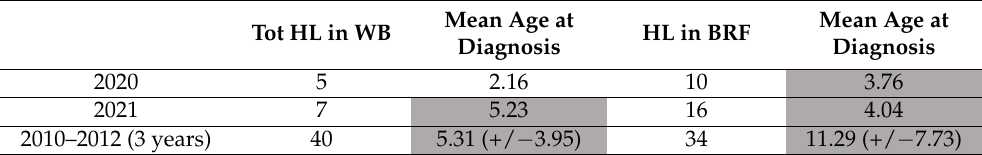
Table 2. Mean age of diagnosis of hearing loss for WB and BRF, a comparision between 2020-2021 and